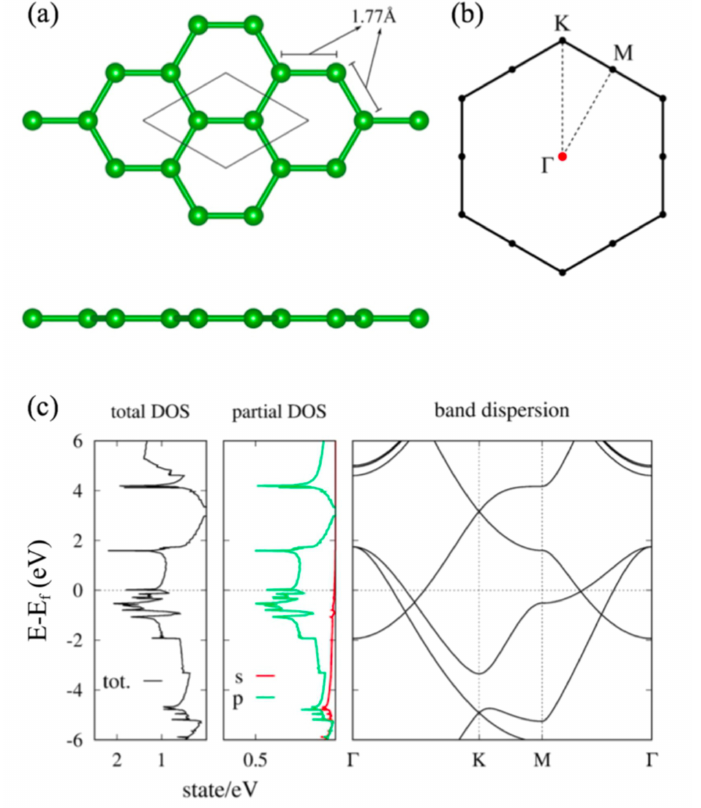
Figure 2. ( a ) Lattice structure and ( b ) BZ of the honeycomb boron sheet. ( c ) Density of states and electronic band dispersion of the honeycomb boron sheet (adapted from